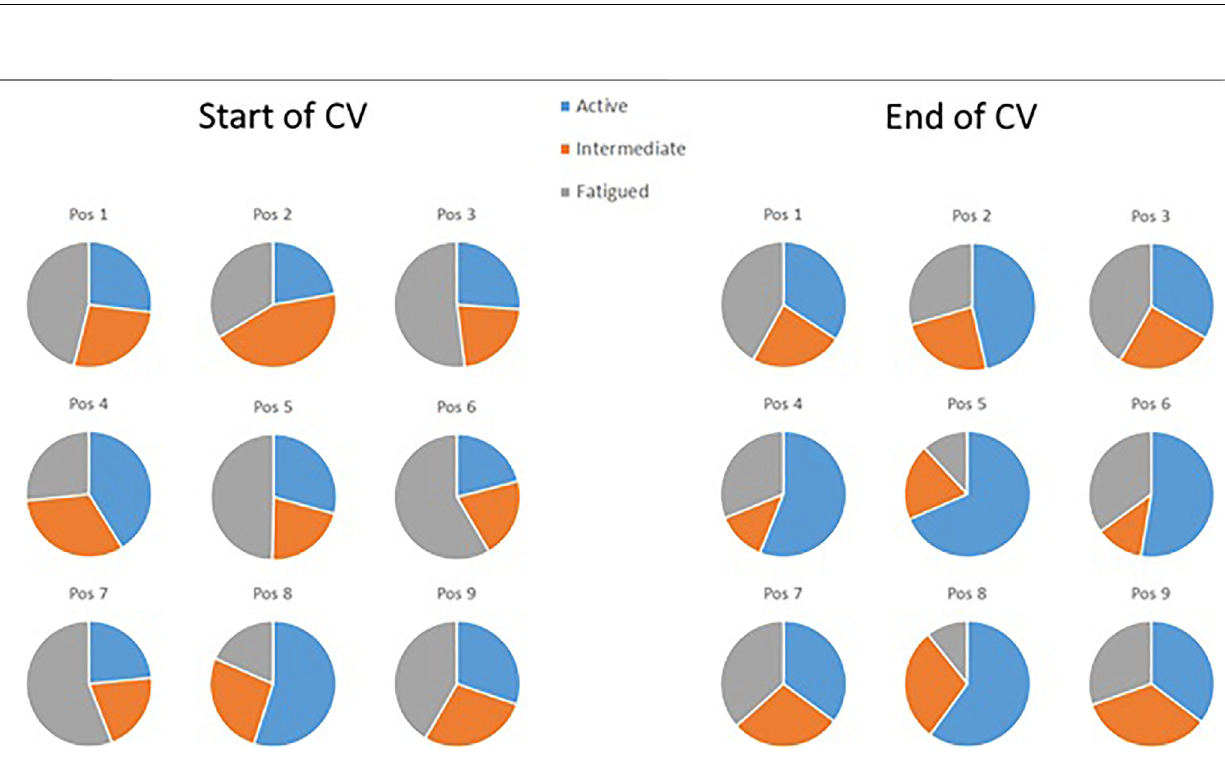
FIGURE7|(A) Theresultsofthe “ 3-phase ” analysisforthreedifferentC-rates,withallmeasurementsatposition5. (B) TheSXRDraw,calculated,andresidualdata forthe0.5 Cmeasurementforposition5at4.3 V,withtheinsetshowingthe003re fl ection inmoredetail. DataResidualwR:11.1%. Plotsfor0.2and0.1 Careshown in Supplementary Figures S3 and S4 , respectively. All measurements were taken on the same cell after 900 cycles at 0.5 C ( Figure 6 ).